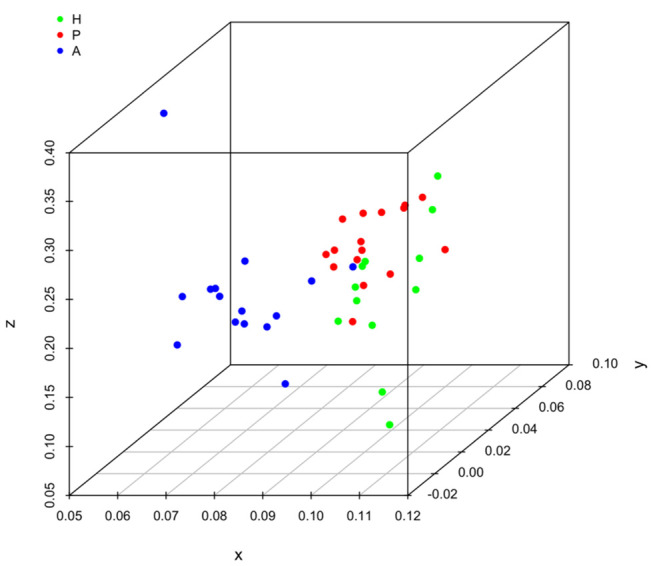
Principal component analysis (PCA) plot for profiles of specialized pro-resolving lipid mediators (SPMs) and lipid mediators (LMs) in human gingival. One dot represents one sample in each group. This plot demonstrates clusters of samples based on their similarity of lipid mediator levels. (H (green): healthy; P (red): periodontitis before non-surgical therapy; A (blue): periodontitis after non-surgical therapy).